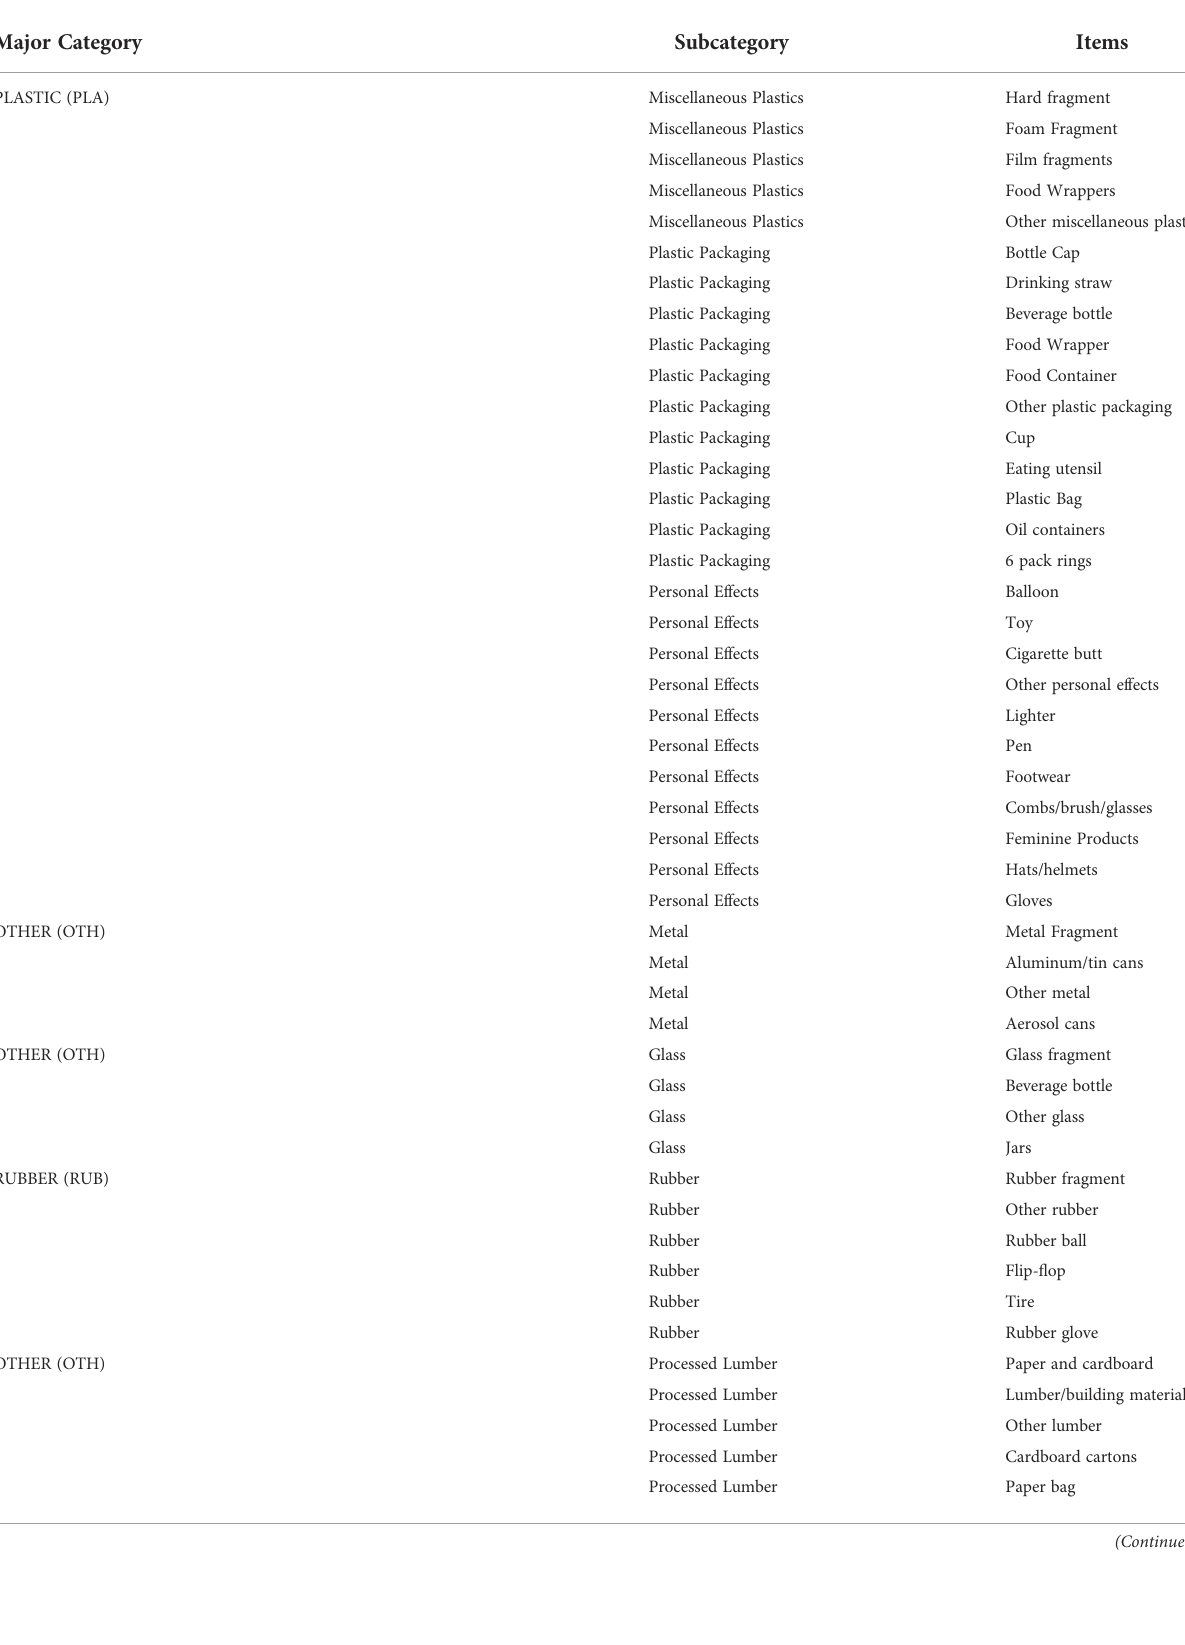
TABLE 1 Major categories and sub-categories used to categorize collected macro-debris adapted from Lippiatt et al. (2013), with the inclusion of subcategories Miscellaneous Plastics, Plastic Packaging and Personal Effects within the major category Plastic, and with the addition of a major category for Abandoned, Lost or Discarded Fishing